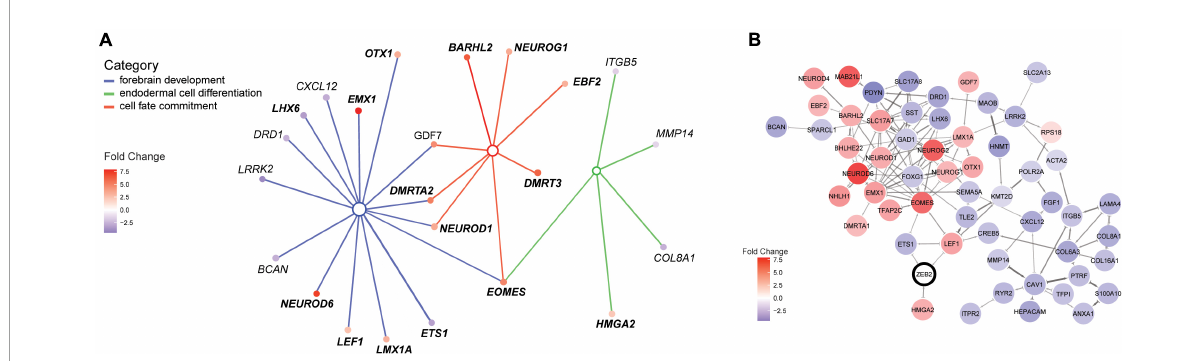
FIGURE3 ZEB2 haploinsufficiency triggers differential expression of factors in a neural regulatory network. (A) Illustration of the interconnected network of DEGs belonging to enriched terms for the biological processes “Forebrain development” [GO:0030900; parent term to dentate gyrus development (GO:0021542); blue lines], “Endodermal cell differentiation” (GO:0035987; green lines) and “Cell fate commitment” (GO:0045165; red lines). The interconnected network was constructed using cnetplot. Interacting DEGs (filled circles) are colored according to gene expression (fold change [log2]). (B) STRING network with confidence edges illustrating documented protein interactions between ZEB2 (circled) and 55 out of 105 DEGs detected in our MW-iPSC derived neural cells at d10 and d65. DEGs (filled circles) are color-coded according to gene expression, as in panel (A) . The Network was generated using a STRING protein query [run in Cytoscape (Doncheva et al., 2019)] with a confidence cut-off = 0.5. ZEB2 is indicated with a bold